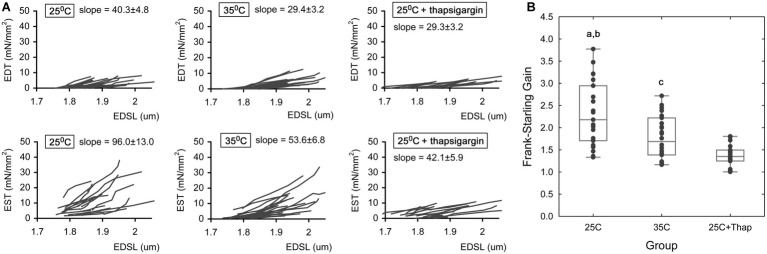
The length-dependent change in active and passive tension in auxotonically contracting isolated rat ventricular cardiomyocytes under different experimental conditions. (A) The individual end-diastolic tension – end-diastolic sarcomere length relationships (the top row of panels) and end-systolic tension – end-diastolic sarcomere length relationships (the bottom row of panels) at room temperature in normal saline (“25C,” N = 4 animals, n = 21 cells); at near-physiological temperature in normal saline (“35C,” N = 3 animals, n = 26 cells); and at room temperature with depleted SERCA2a by thapsigargin (“25C + Thap,” N = 3 animals, n = 18 cells). EDT – end-diastolic tension, EST – end-systolic tension, EDSL – end-diastolic sarcomere length. The slopes derived from linear approximation of each individual relationship were averaged and indicated as mean ± S.E.M., units are mN/mm2 per one μm of SL. All scales are the same throughout. (B) The dimensionless Frank-Starling Gain obtained for the same cells of these groups as a ratio of slopes of EST-EDSL and EDT-EDSL relationships. Scatter-plots of raw data (dots), median value (central horizontal line in the boxes), and 25–75% percentiles are shown. a – significant difference between “25C” and “35C”; b – significant difference between “25C” and “25C + Thap”; c – significant difference between “35C” and “25C + Thap” (Student’s two-sided t-test, p < 0.05).